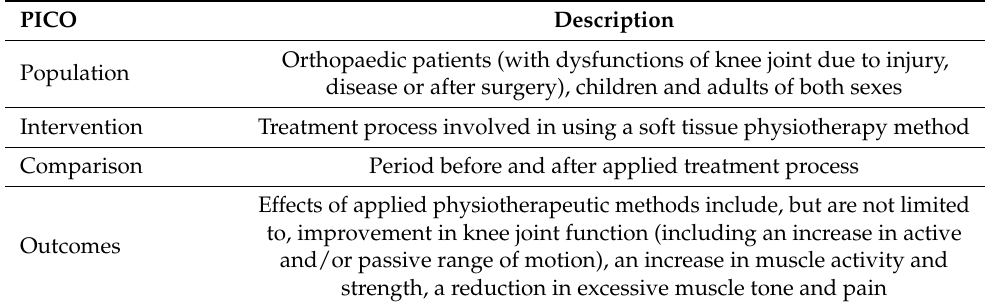
Table 1. Search criteria based on the PICO model. PICO